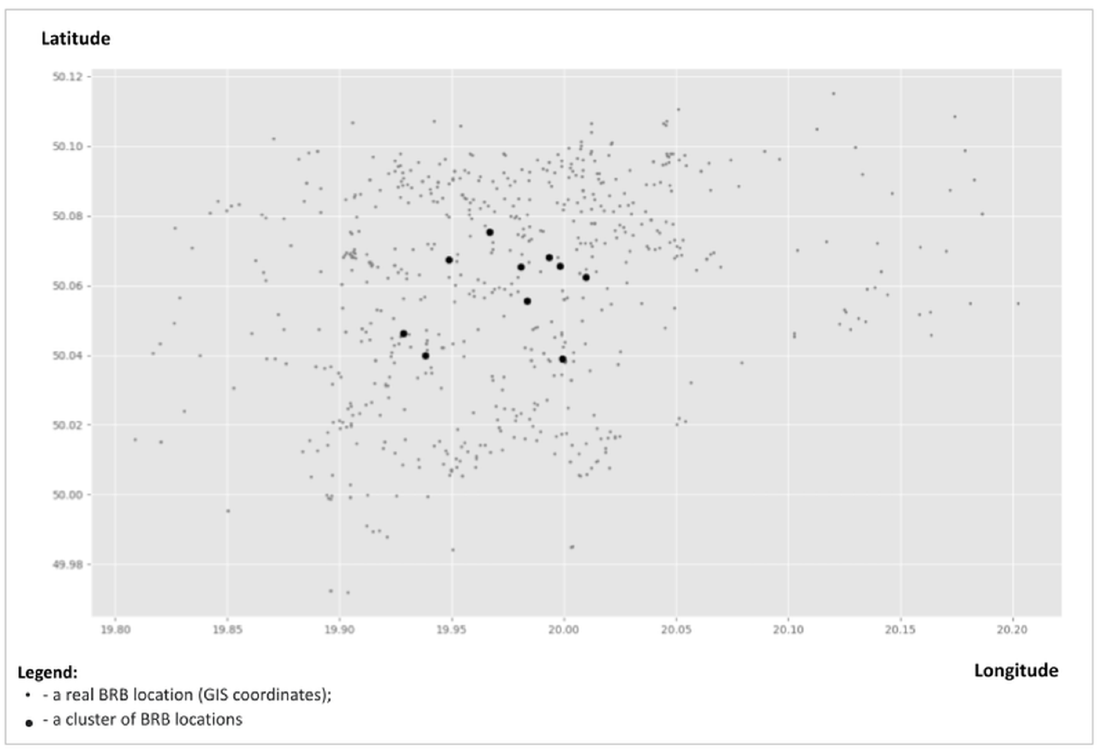
Figure 3. Clustering 639 BRBs locations to 10 pickup points using k -mean